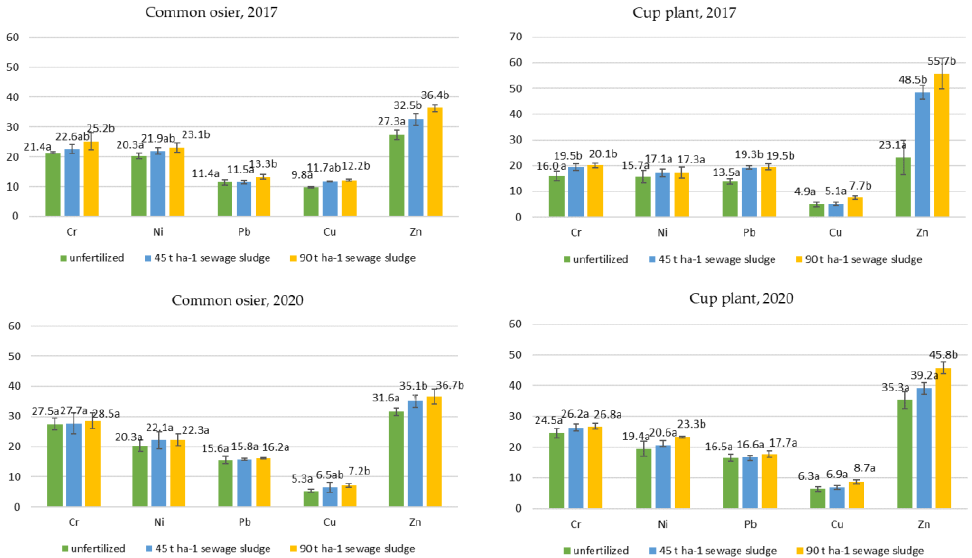
Figure 2. The content of heavy metals in the soil at different rates of an application of the sewage sludge. Different lowercase letters indicate significant differences among treatments.